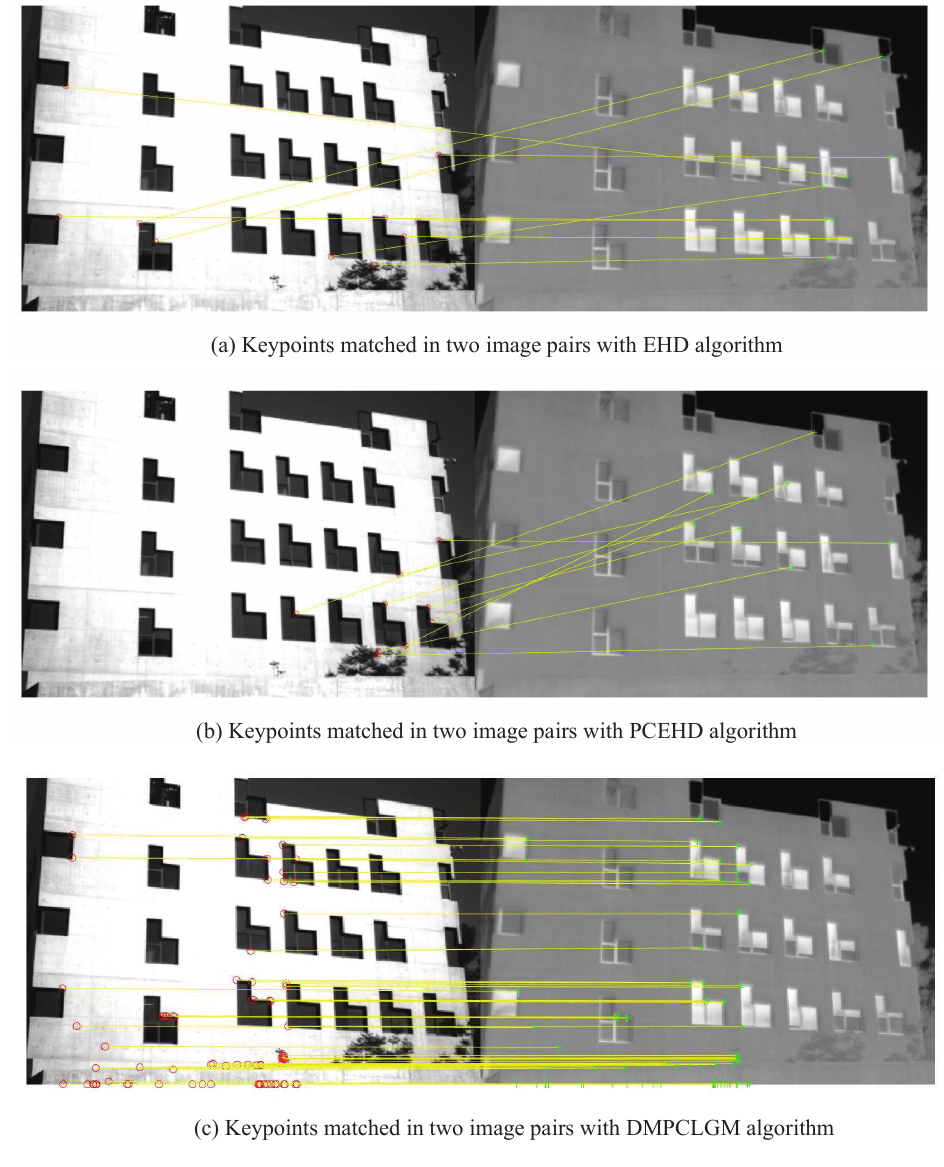
Figure 12. Keypoints matched in two image pairs. Table 3. Comparison of the six algorithms using the RGB-NIR data